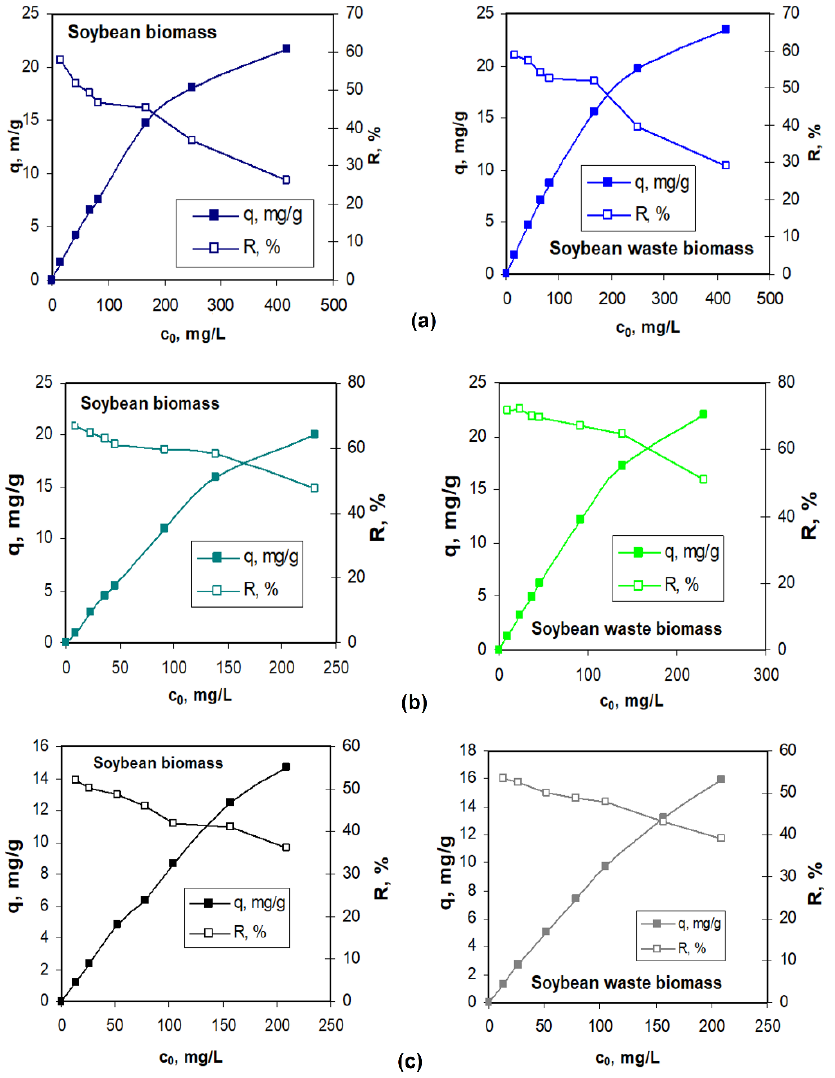
Figure 6. Influence of the initial concentration of metal ions on the biosorption capacity and bio- sorption efficiency of ( a ) Pb(II), ( b ) Cd(II), and ( c ) Zn(II) ions on soybean biomass and soybean waste (pH = 3.39; biosorbent dose = 5.0 g/L; contact time = 24 h; temperature = 22 °C).